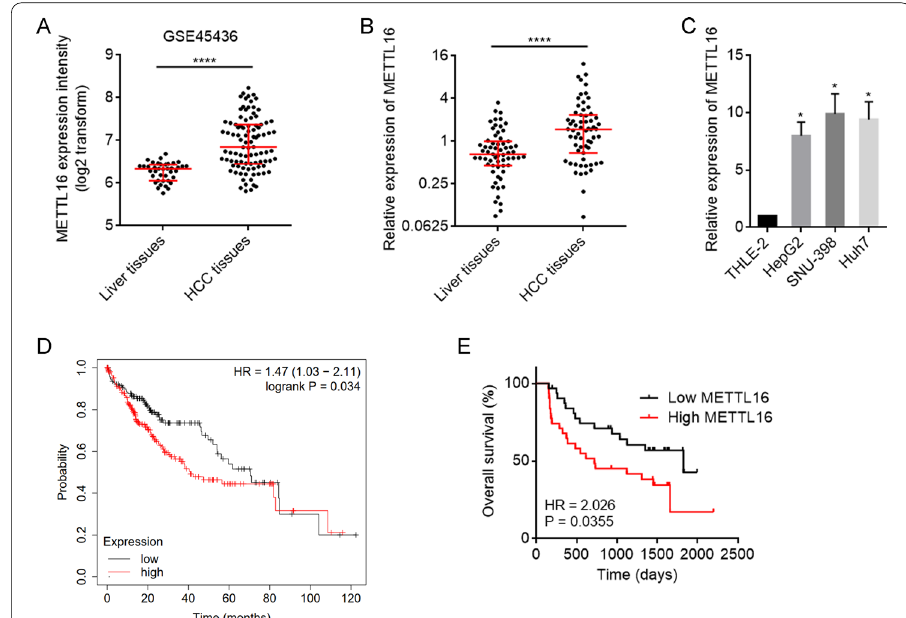
Fig. 1 The expression pattern and clinical association of METTL16 in HCC. A METTL16 mRNA expression in human HCC tissues ( n 95) and normal liver tissues ( n 39) from GSE45436 dataset. **** P < 0.0001 by = = Mann–Whitney test. B METTL16 mRNA expression level in 63 pairs of HCC tissues and matched adjacent noncancerous liver tissues was measured by RT‑qPCR. **** P < 0.0001 by Wilcoxon signed‑rank test. C METTL16 mRNA expression level in HCC cell lines HepG2, SNU‑398, Huh7, and normal hepatic cell line TLHE‑2 was measured by RT‑qPCR. Results are shown as mean standard deviation (SD) of n 3 independent ± = experiments. * P < 0.05 by one‑way ANOVA followed by Dunnett’s multiple comparisons test. D Kaplan–Meier survival analysis of the correlation between METTL16 mRNA expression and overall survival based on TCGA liver cancer data, analyzed by the online in silico tool Kaplan–Meier Plotter (https:// kmplot. com/ analy sis/). E Kaplan–Meier survival analysis of the correlation between METTL16 mRNA expression and overall survival in our HCC cohort. n 63 patients with HCC. P 0.0355 by log‑rank test. Median METTL16 level was used as = =